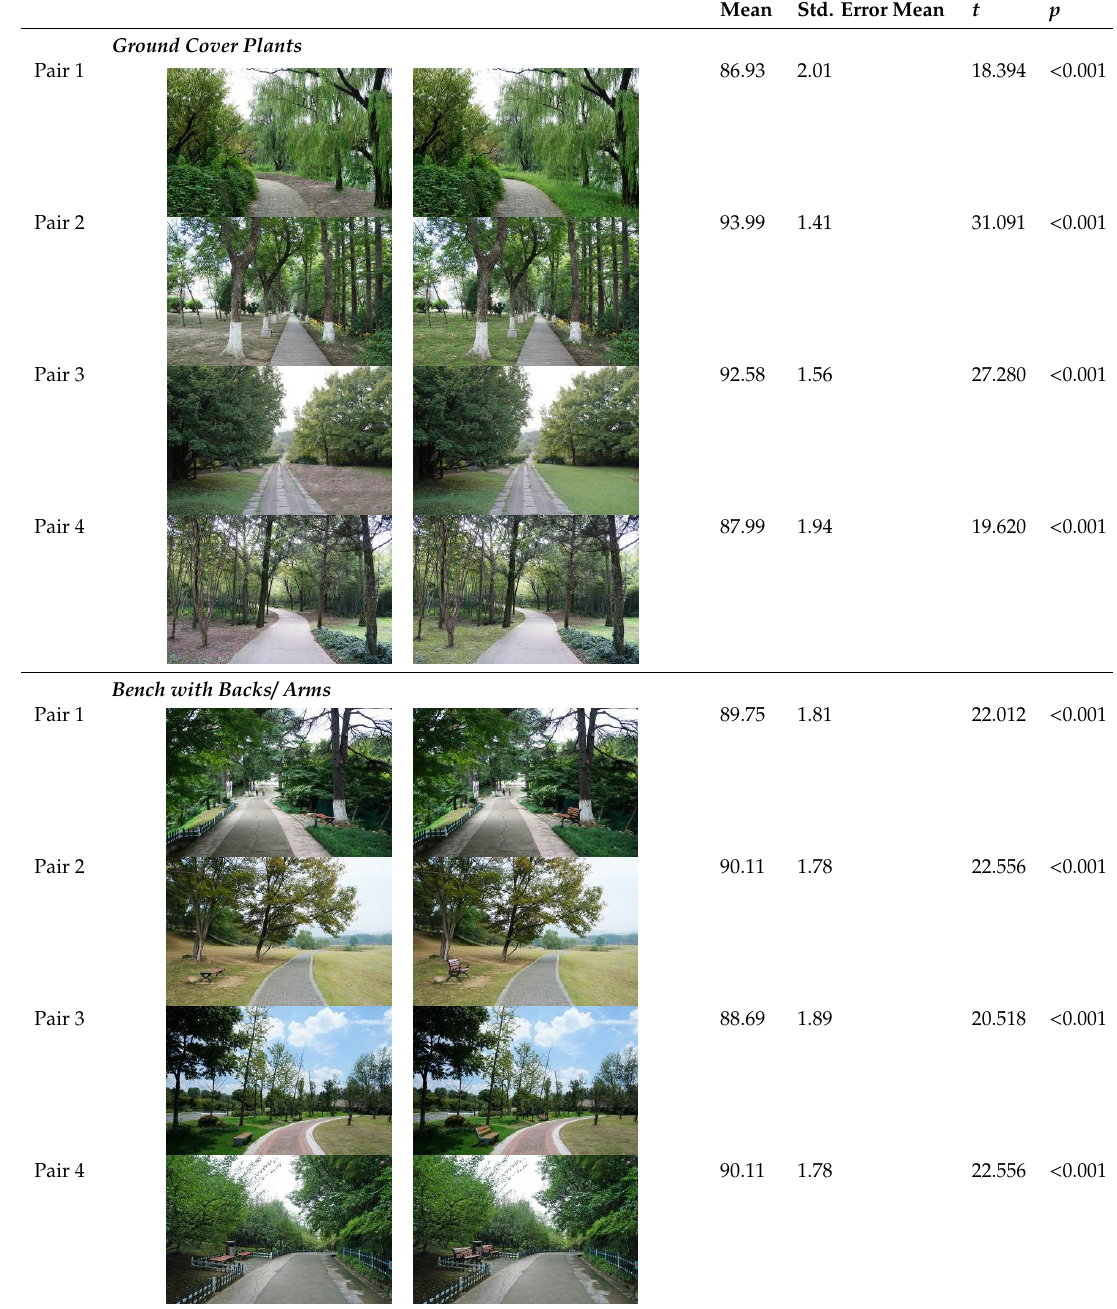
Table A1. All of the 28 paired images (four pairs for each feature) and preference for each photo example. Ground Cover